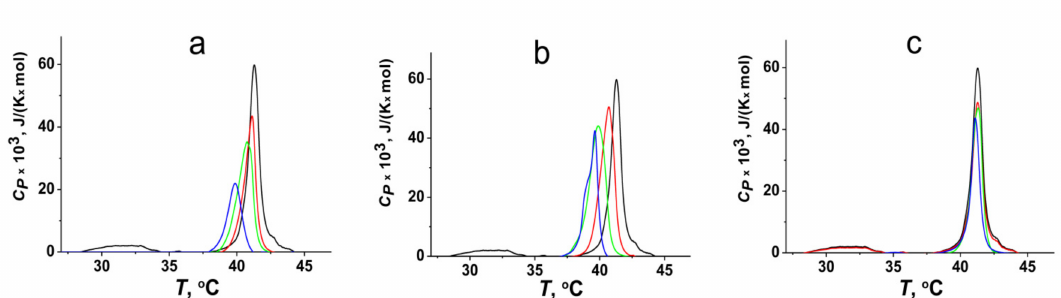
Figure 3. Heating thermograms of DPPC unilamellar liposomes in the absence (control, black line) and presence of sildenafil ( a ), vardenafil ( b ), and tadalafil ( c ) in the liposome suspension at concentrations of 10 µ M (red lines), 50 µ M (green lines), and 100 µ M (blue lines).